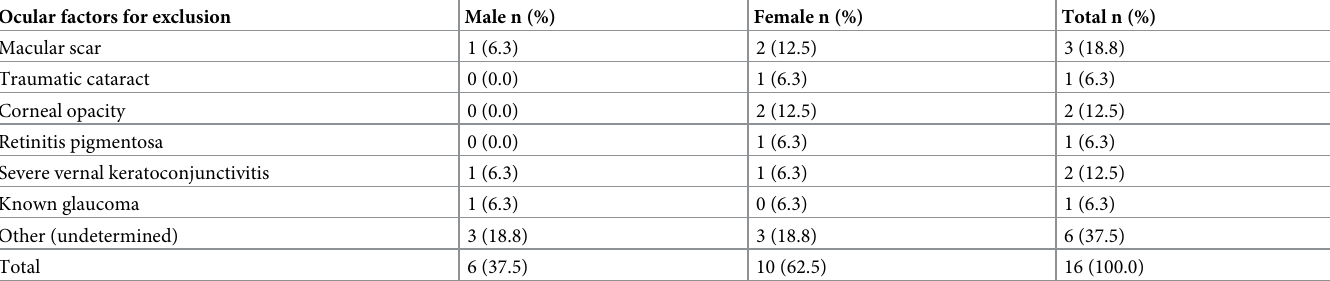
Table 2. Ocular factors for exclusion from spectacle correction and referral.